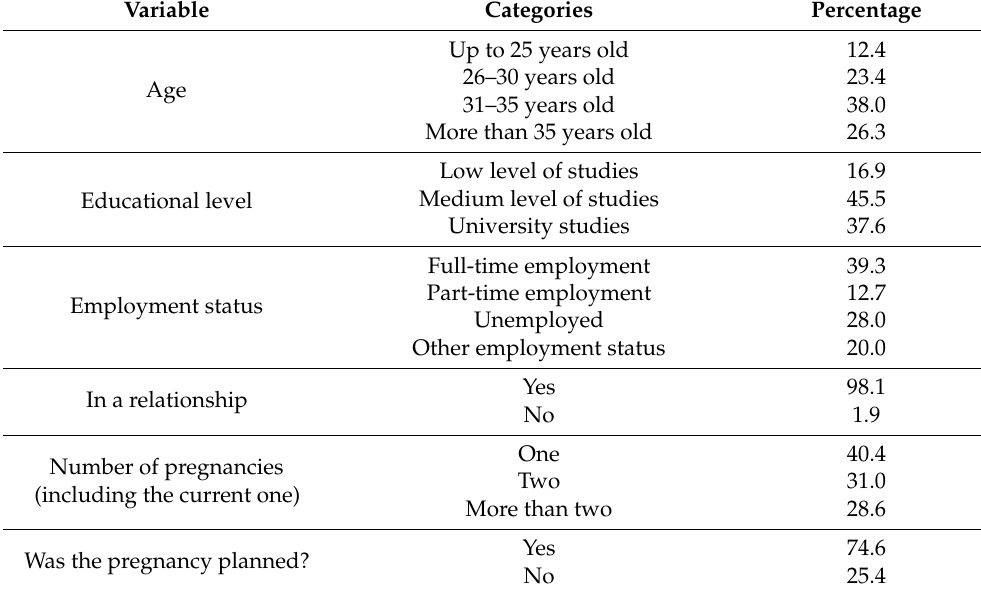
Table 1. Descriptive characteristics of the